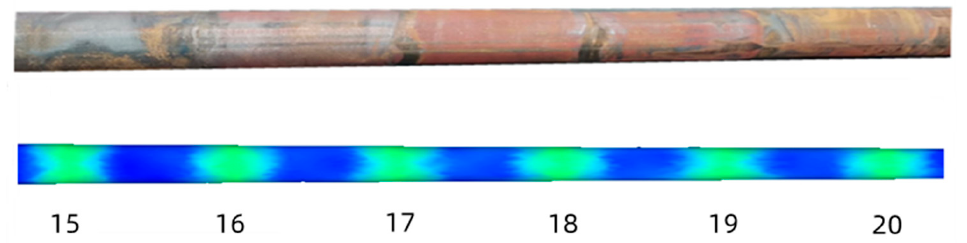
Figure 11. Modified model simulation and object plug comparison.